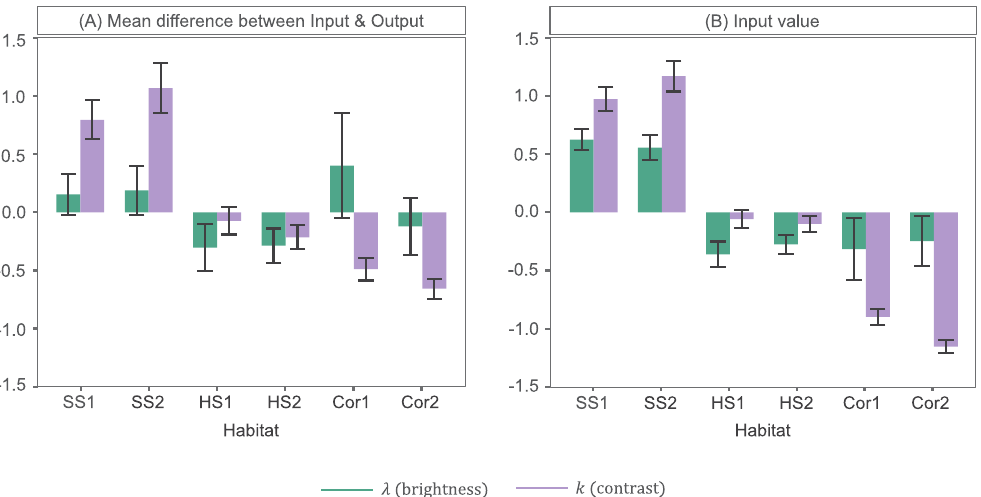
Figure 13. WTM parameter variation with image class (habitat): ( A ) mean difference in WTM parameters between input and output WD and ( B ) mean WD parameters across input images. All values are presented as standardised Z − Scores for fair comparison. The λ and k differences in ( A ) refer only to cases in which they were decreased and increased, respectively. Error bars represent 95% confidence